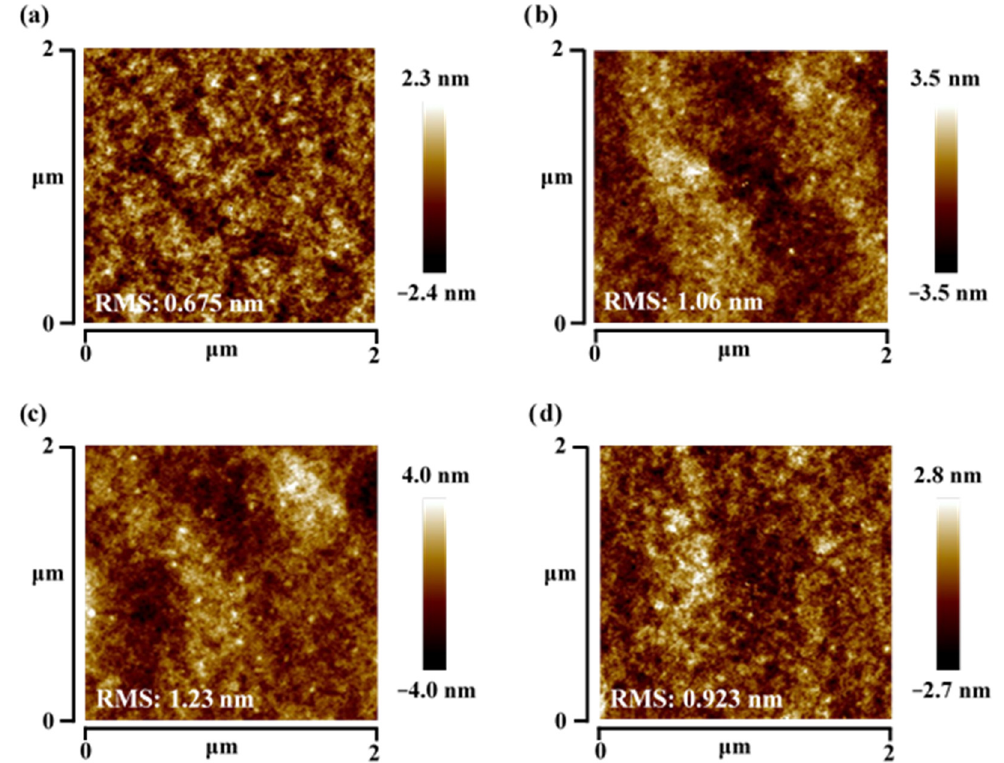
Figure 5. AFM images of P3HT:DDCI4:OXCBA thin film for ( a ) 0 mg/mL of DDCI-4; ( b ) 3 mg/mL of DDCI-4; ( c ) 5 mg/mL of DDCI-4; ( d ) 7 mg/mL of DDCI-4 with a scan size of 2 μ m x 2 μ m.